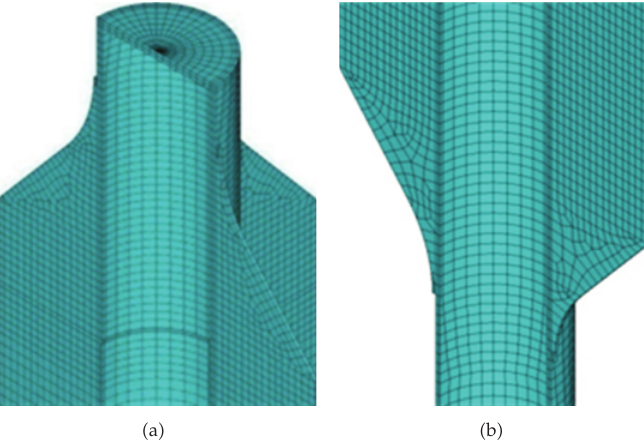
Figure 5: General view of a FE mesh for a torpedo anchor: (cid:3) a (cid:4) top and (cid:3) b (cid:4) bottom part of the flukes. R = L + E Node where the load is applied Rigid bars